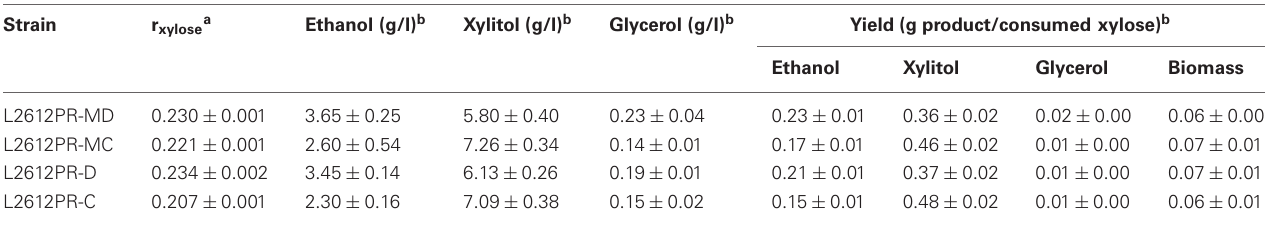
L2612PR-C were the corresponding control strains. Figure legends: squares, xylose consumption; triangles, xylitol concentration; circles, ethanol concentration. The concentration of glycerol is not presented (see Table 6 ). The results shown were the average value of two independent